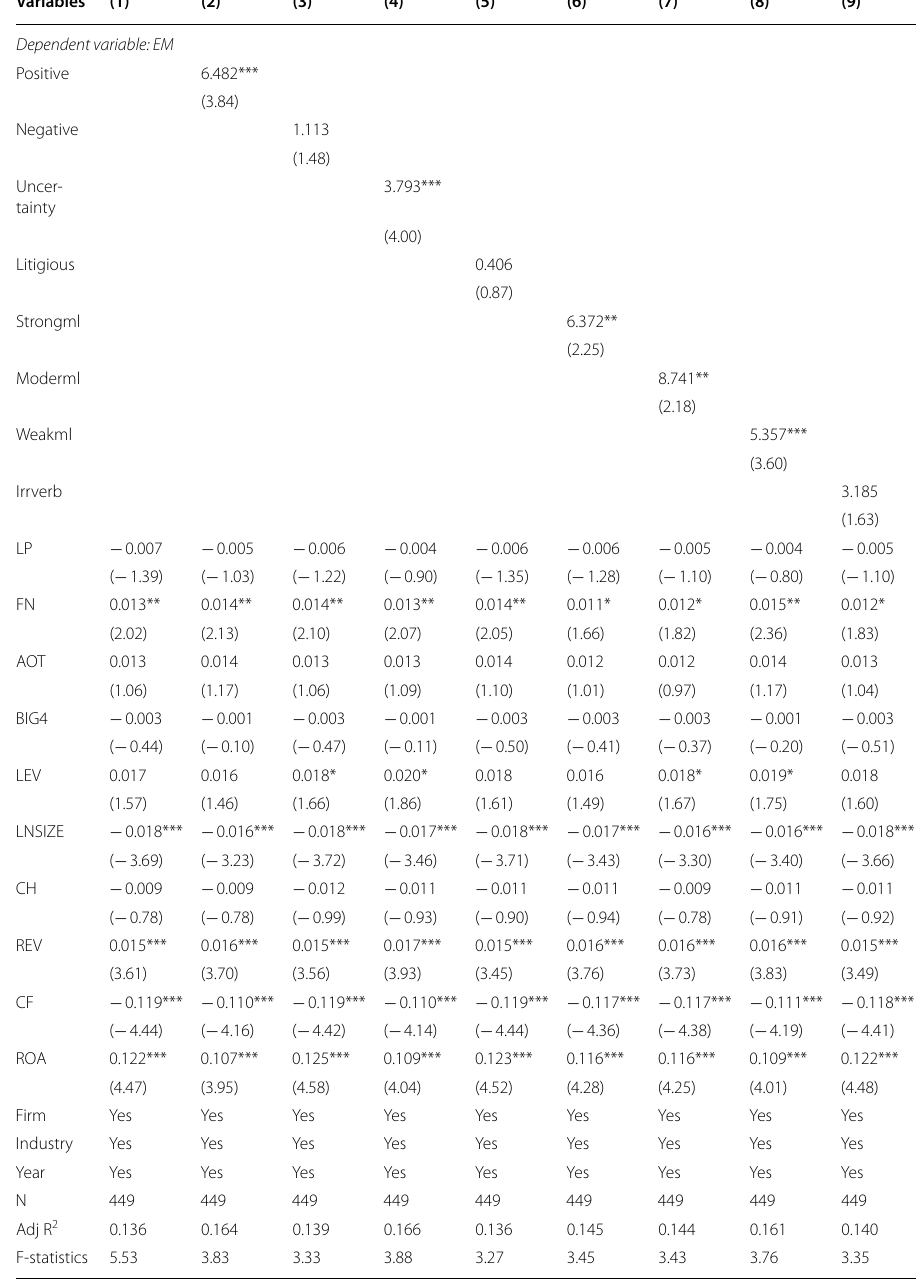
Table 3 OLS Regression on earnings